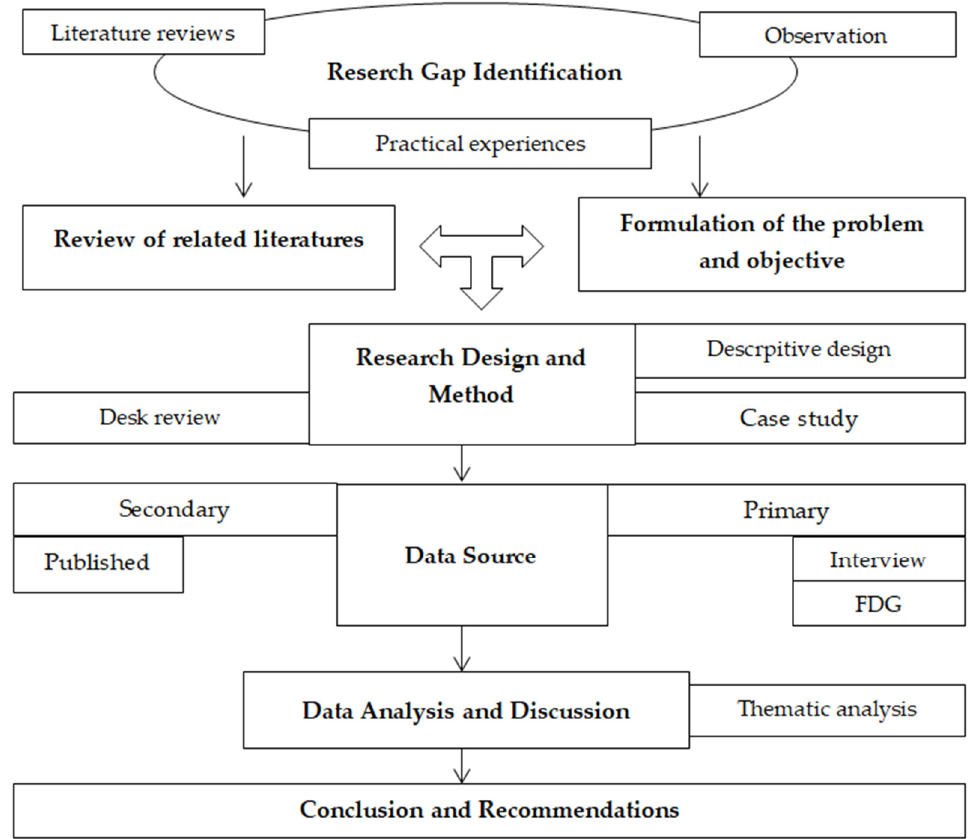
Figure 1. Overall research design.